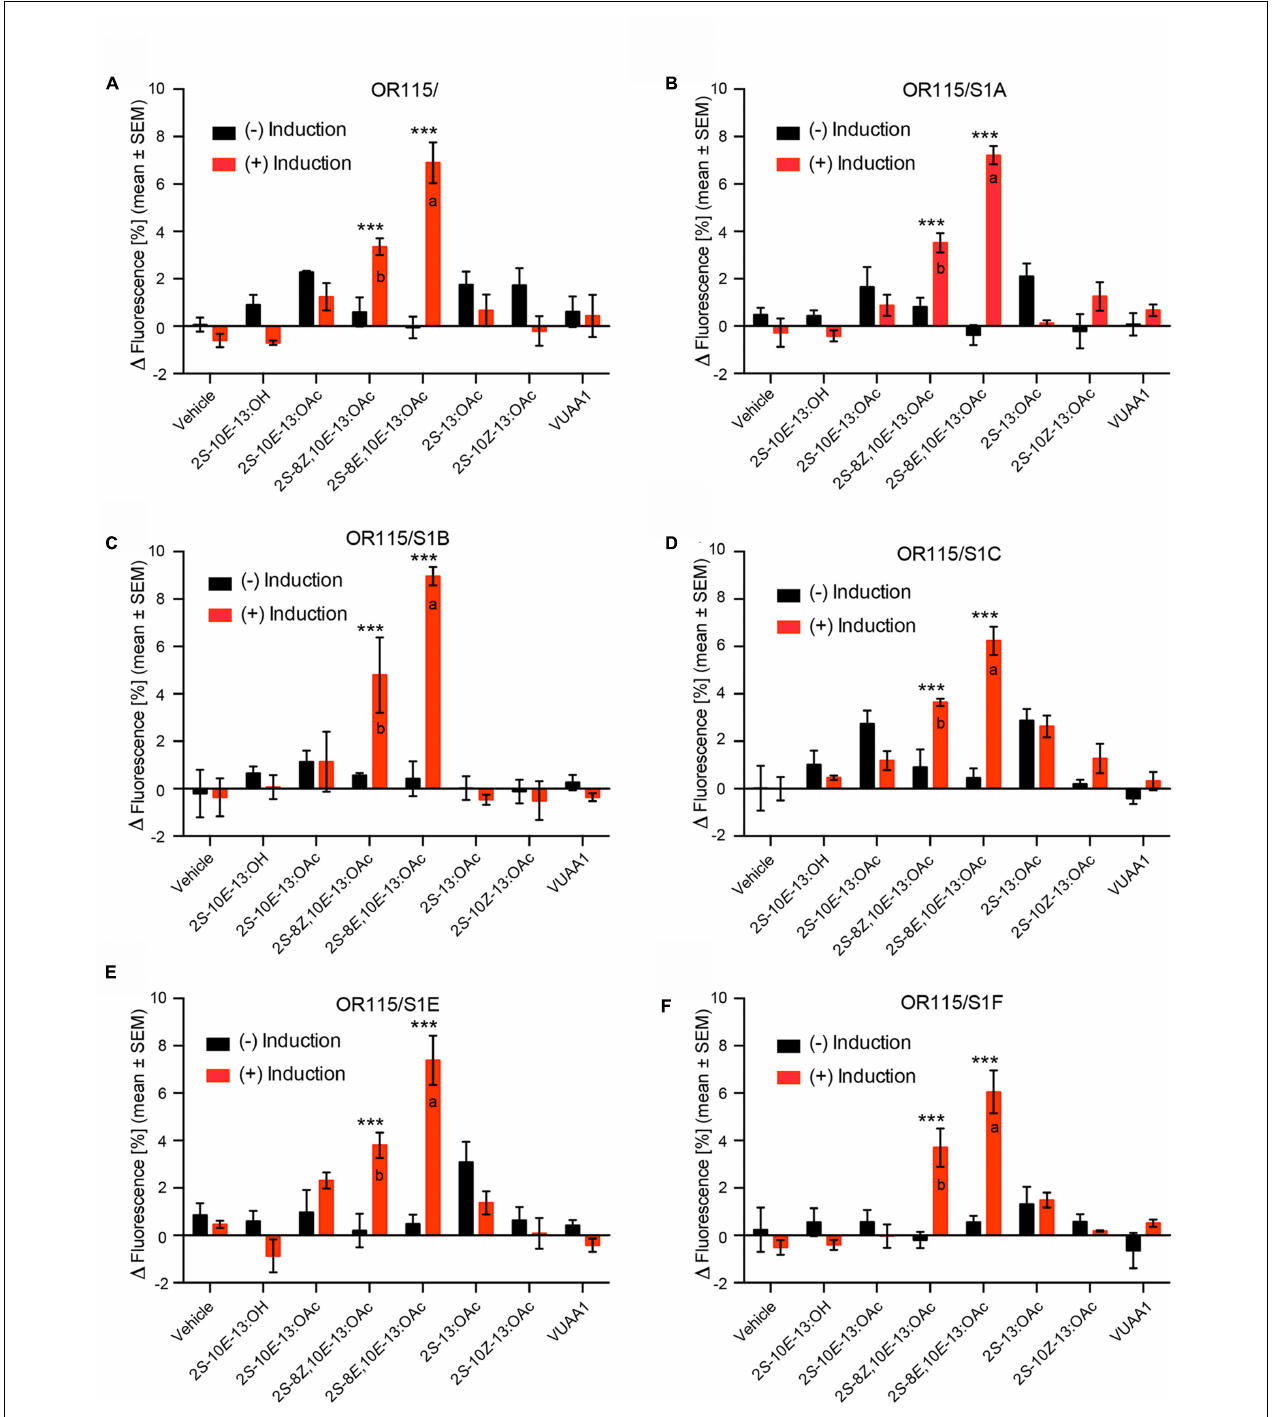
FIGURE 2 | Responses of six HEK293/TMO/MdesOR115 cell lines, with or without SNMP1 (S1), to Hessian fly sex pheromone components (10 µ M concentration), including both induced cells (red bars) and non-induced cells (black bars). Shown are also responses to vehicle control (0.5% DMSO) and the Orco agonist VUAA1 (50 µ M). Asterisks indicate significant differences between non-induced and induced cells (all p < 0.001). Different lower-case letters indicate significant (all p < 0.007) differences between the response to 2 S -8 Z ,10 E -13:OAc and 2 S -8 E ,10 E -13:OAc. Means ( ± SEM) are derived from three biological replicates ( n = 3), each including three technical replicates (i.e., total n = 9). Cell lines: (A) HEK293/TMO/MdesOR115, (B) HEK293/TMO/MdesOR115/SNMP1A, (C) HEK293/TMO/MdesOR115/SNMP1B, (D) HEK293/TMO/MdesOR115/SNMP1C, (E) HEK293/TMO/MdesOR115/SNMP1E, (F) HEK293/TMO/MdesOR115/